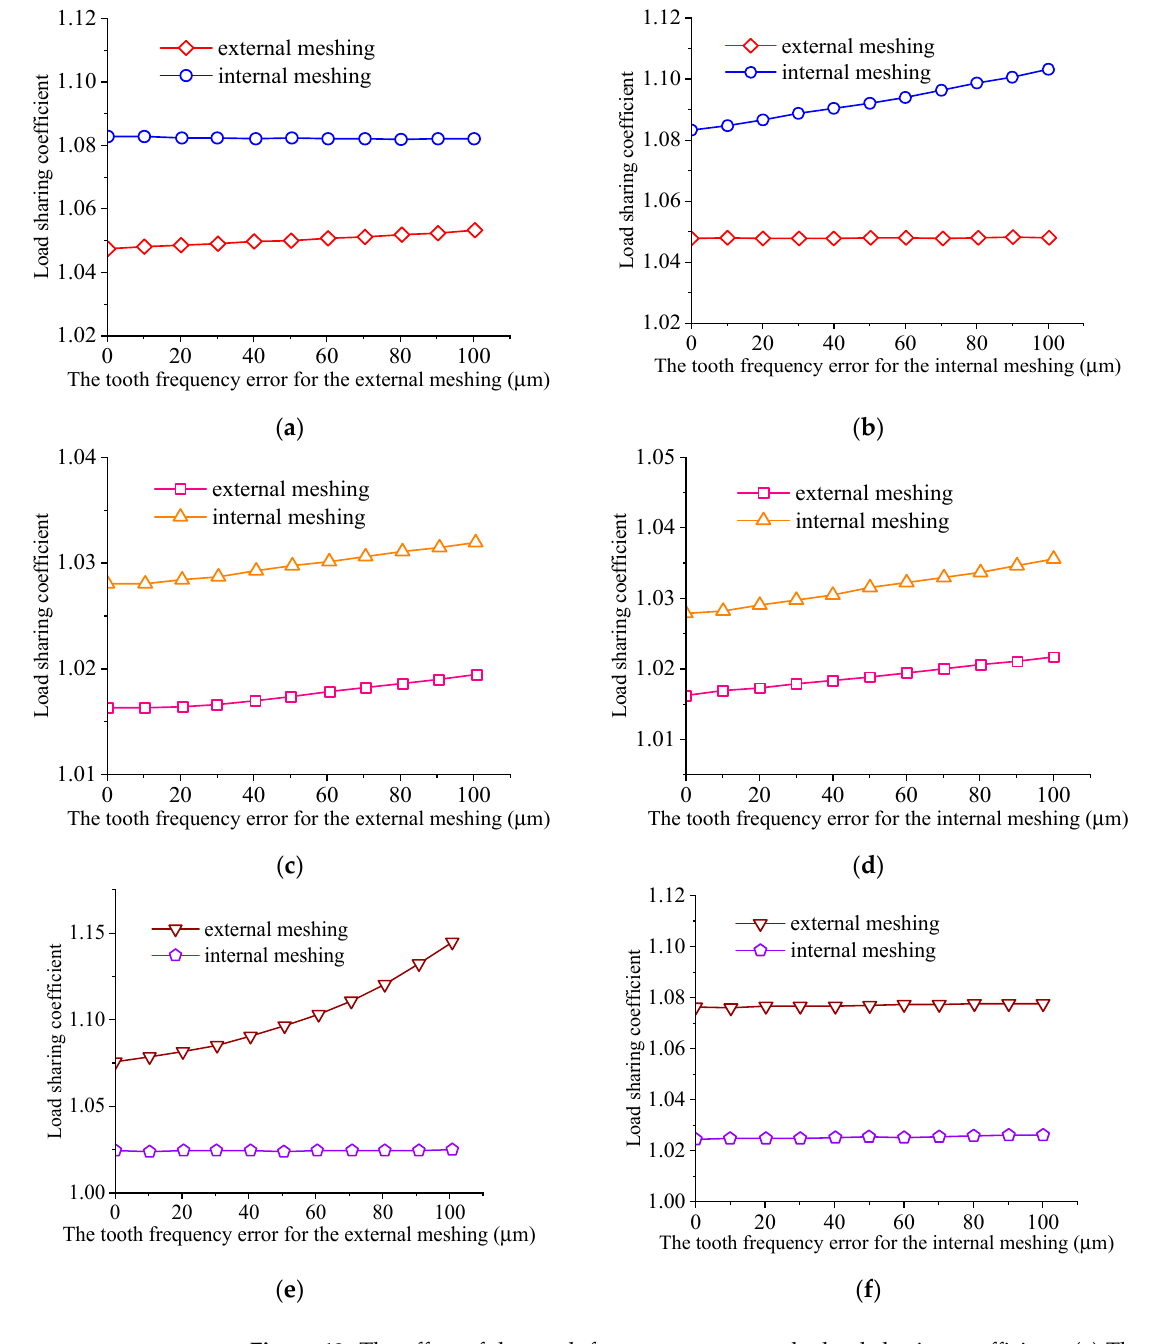
Figure 12. The effect of the tooth frequency error on the load sharing coefficient. ( a ) The external meshing in the first stage; ( b ) the internal meshing in the first stage; ( c ) the external meshing in the second stage; ( d ) the internal meshing in the second stage; ( e ) the external meshing in the third stage; ( f ) the internal meshing in the third stage.